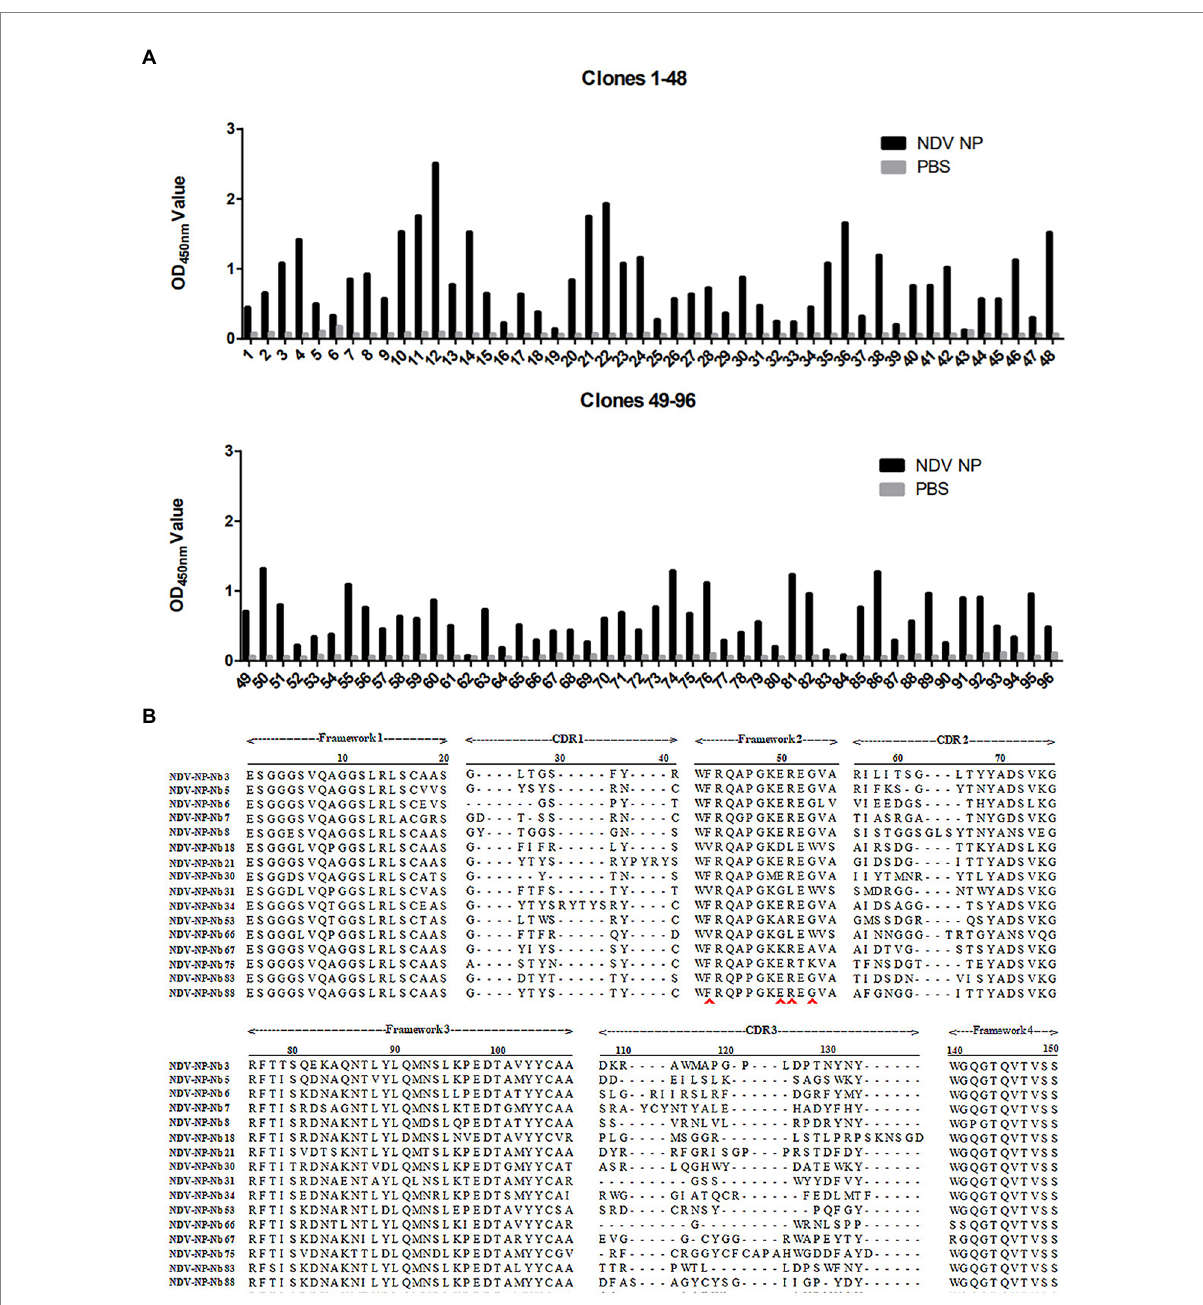
FIGURE 1 Screening of specific nanobodies against the Newcastle disease virus (NDV) NP protein. (A) Detection of the periplasmic extracts containing recombinant nanobodies from 96 clones reacting with NDV NP proteins with indirect ELISA. (B) Alignment of amino acid sequences of the 16 screened nanobodies. The frameworks and CDRs were labelled according to that described in a previous study, and the residues at positions 37, 44, 45, and 47 that are characteristic of nanobodies are indicated by the red